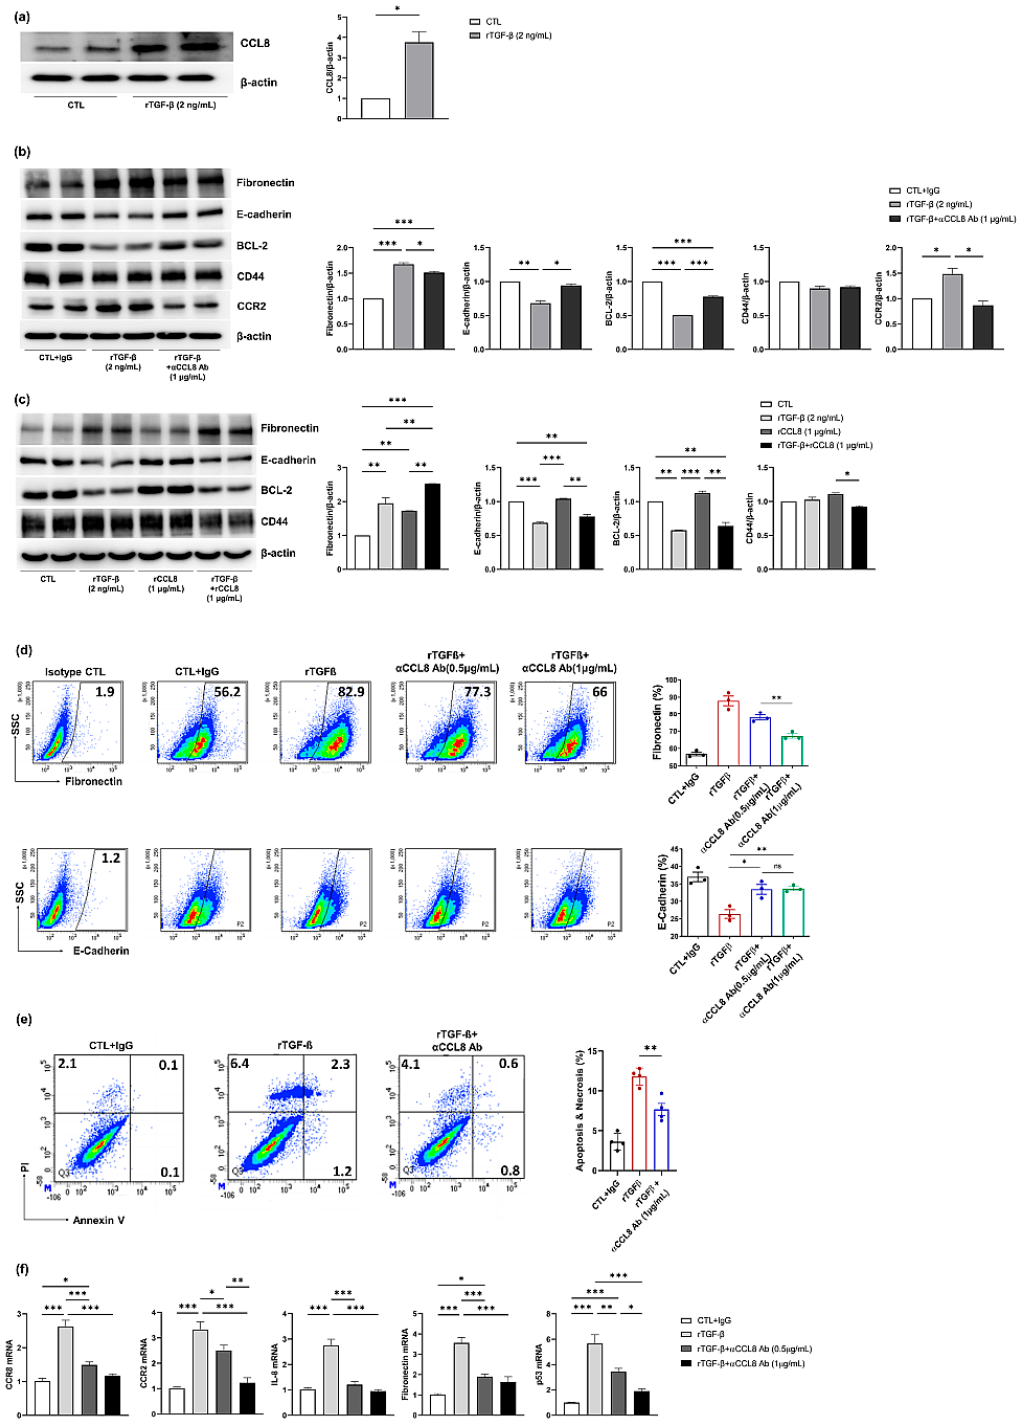
Figure 5. Western blot analysis of primary cultured hTECs after induction of fibrosis with rTGF- β (2 ng/mL). CCL8 was up-regulated by rTGF- β treatment ( a ). rTGF- β increased fibronectin and CCR2 and decreased E-cadherin and BCL-2 protein expression. The simultaneous treatment with anti-CCL8 mAb at 1.0 µ g/mL, mitigated the rTGF- β -induced increase in fibronectin and CCR2 and decrease E-cadherin and BCL-2 protein levels. Bars represent means ± SDs ( b ). rCCL8 alone had no direct effect on increasing in fibronectin expression. The simultaneous treatment with rTGF- β and